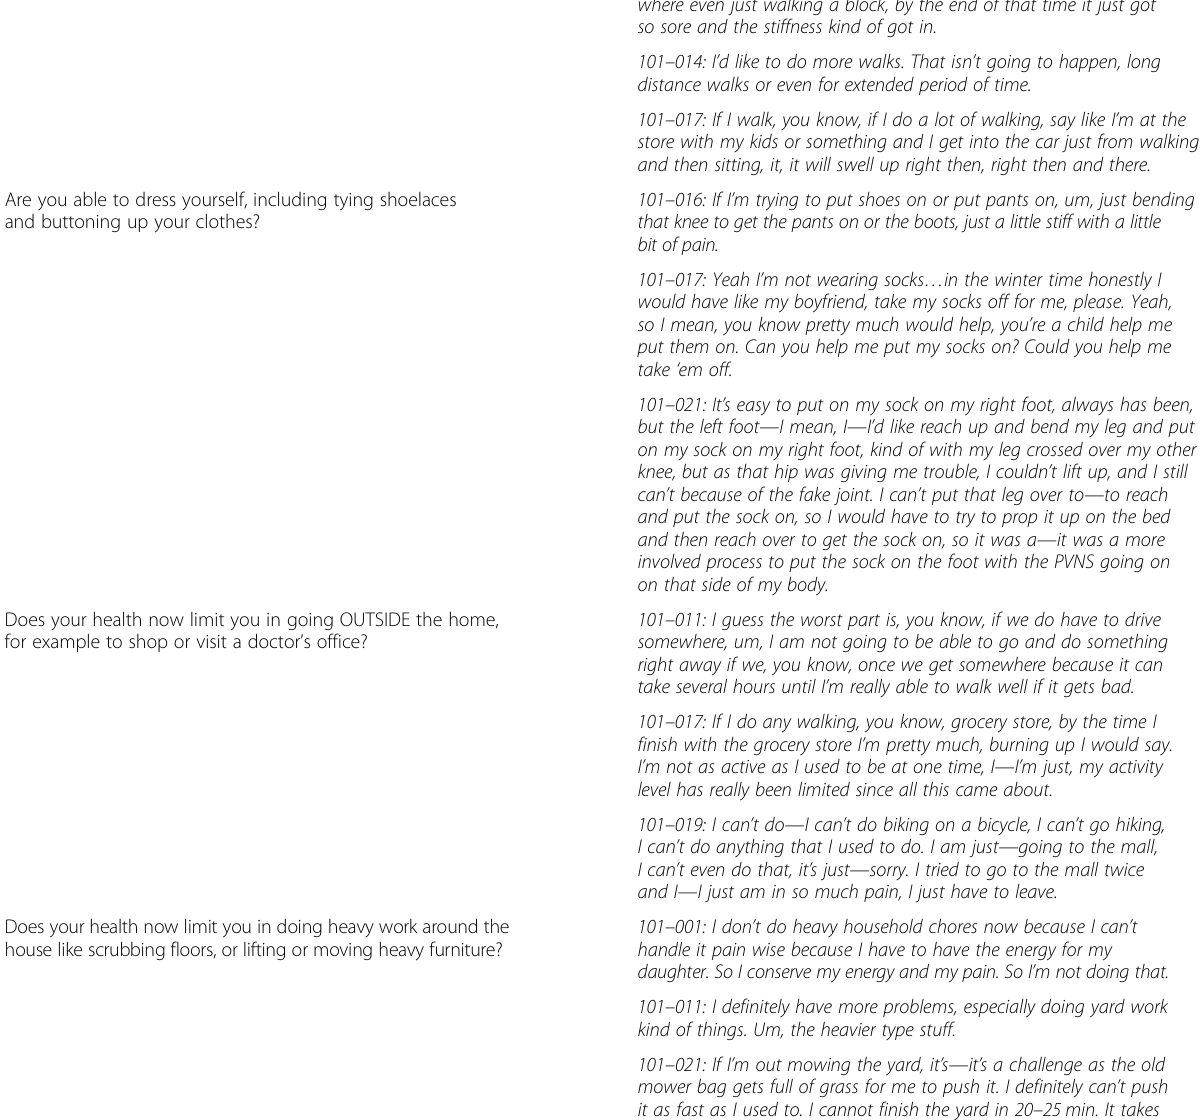
Table 1 Selected patient quotes targeting PROMIS-PF item concepts Are you able to go for a walk of at least 15